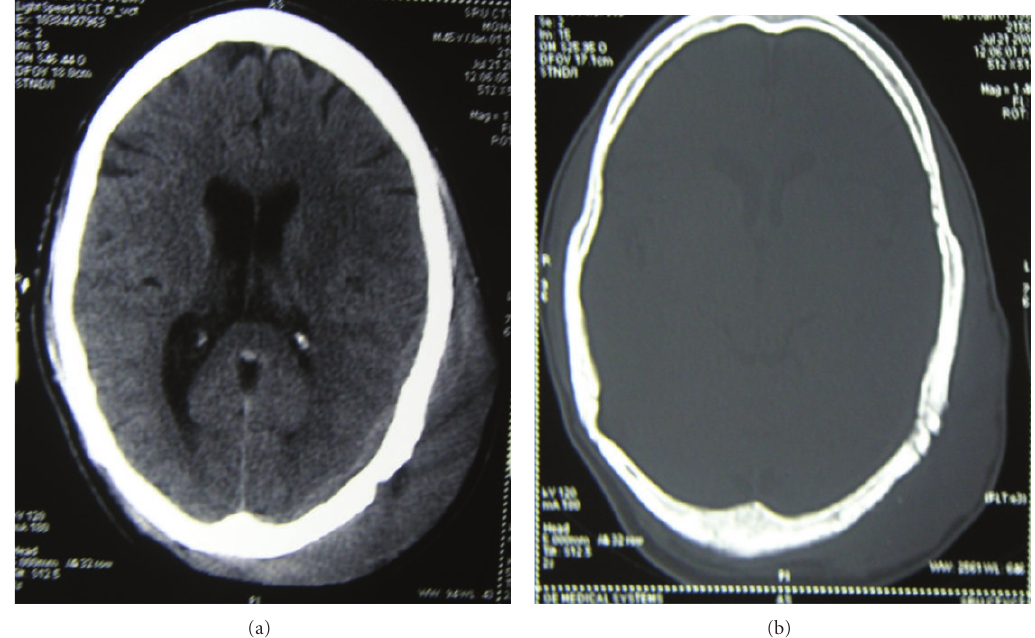
Figure 2: (a) CT scan axial section of the head showing scalp swelling in the left temporoparietal region after partial excision of the mass. (b) CT scan axial section showing scalp swelling after partial excision of the